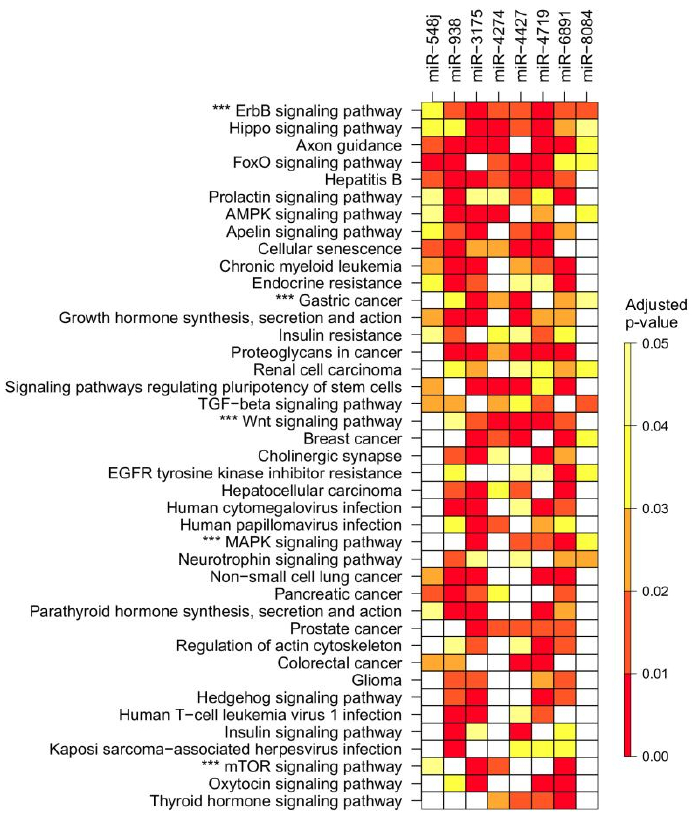
Figure 4. A heatmap of the most enriched pathways of the eight miRNAs analyzed is shown. A total of 41 pathways were targeted by at least half (50%) of the studied miRNAs. Remarkably, the “gastric cancer” pathway was targeted by six miRNAs. This pathway involved other displayed pathways (***) demonstrating the redundancy of these findings. Adjusted p -value after Bonferroni correction for multiple comparisons.